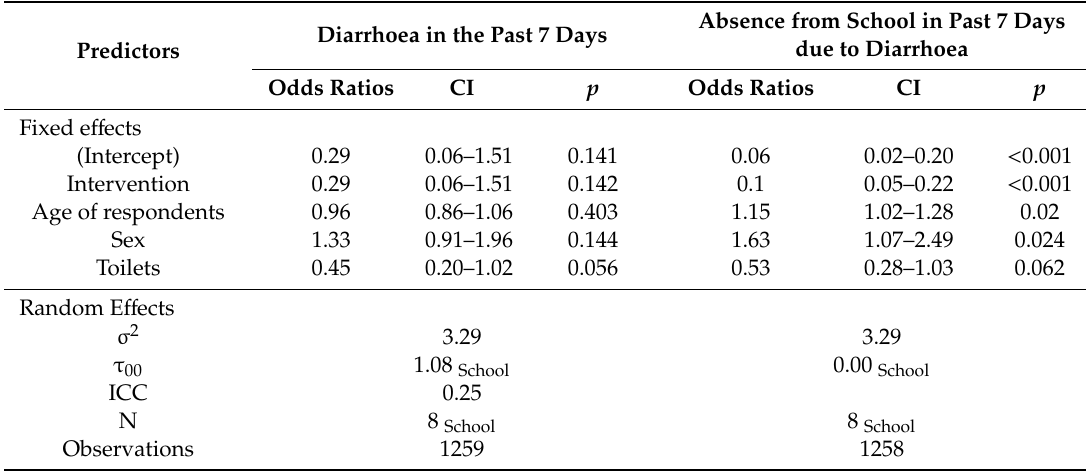
Table 6. Multilevel models showing the e ff ect of the intervention on (1) diarrhoea in the past 7 days (n = 1259) and (2) absence from school in the past 7 days due to diarrhoea (n =